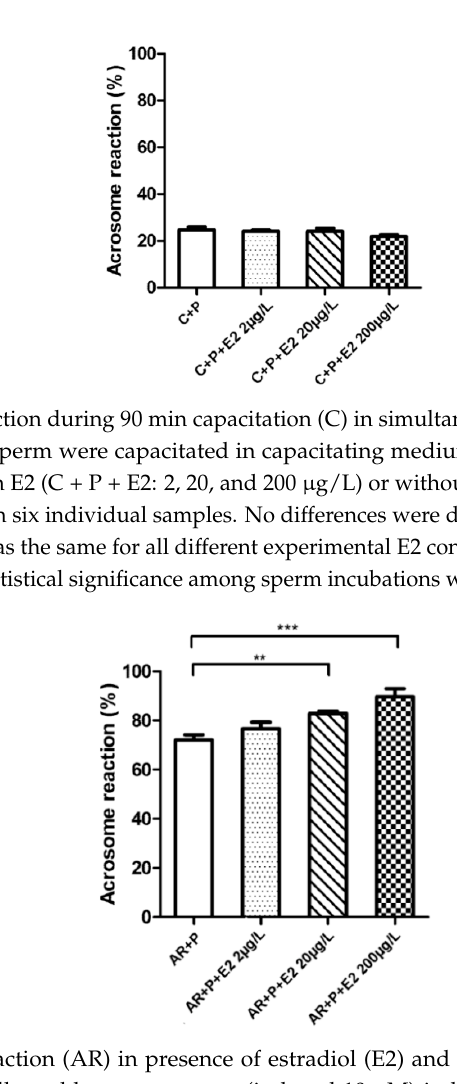
Figure 7. Acrosome reaction (AR) in presence of estradiol (E2) and progesterone (P). Sperm were capacitated (90 min) followed by progesterone (induced 10 µ M) induced AR (90 min) in presence of E2 (AR + P + E2 2; 20 and 200 µ g/L) or without E2 (control, AR + P). The results show an E2 dose-dependent increase in AR rate. A total of 200 cells were counted in six individual samples. Error bars indicate the SD. ** p < 0.01, *** p ≤ 0.001.